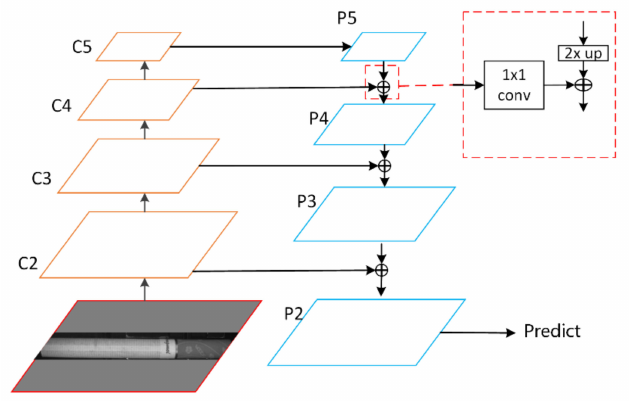
Figure 5. Feature pyramid